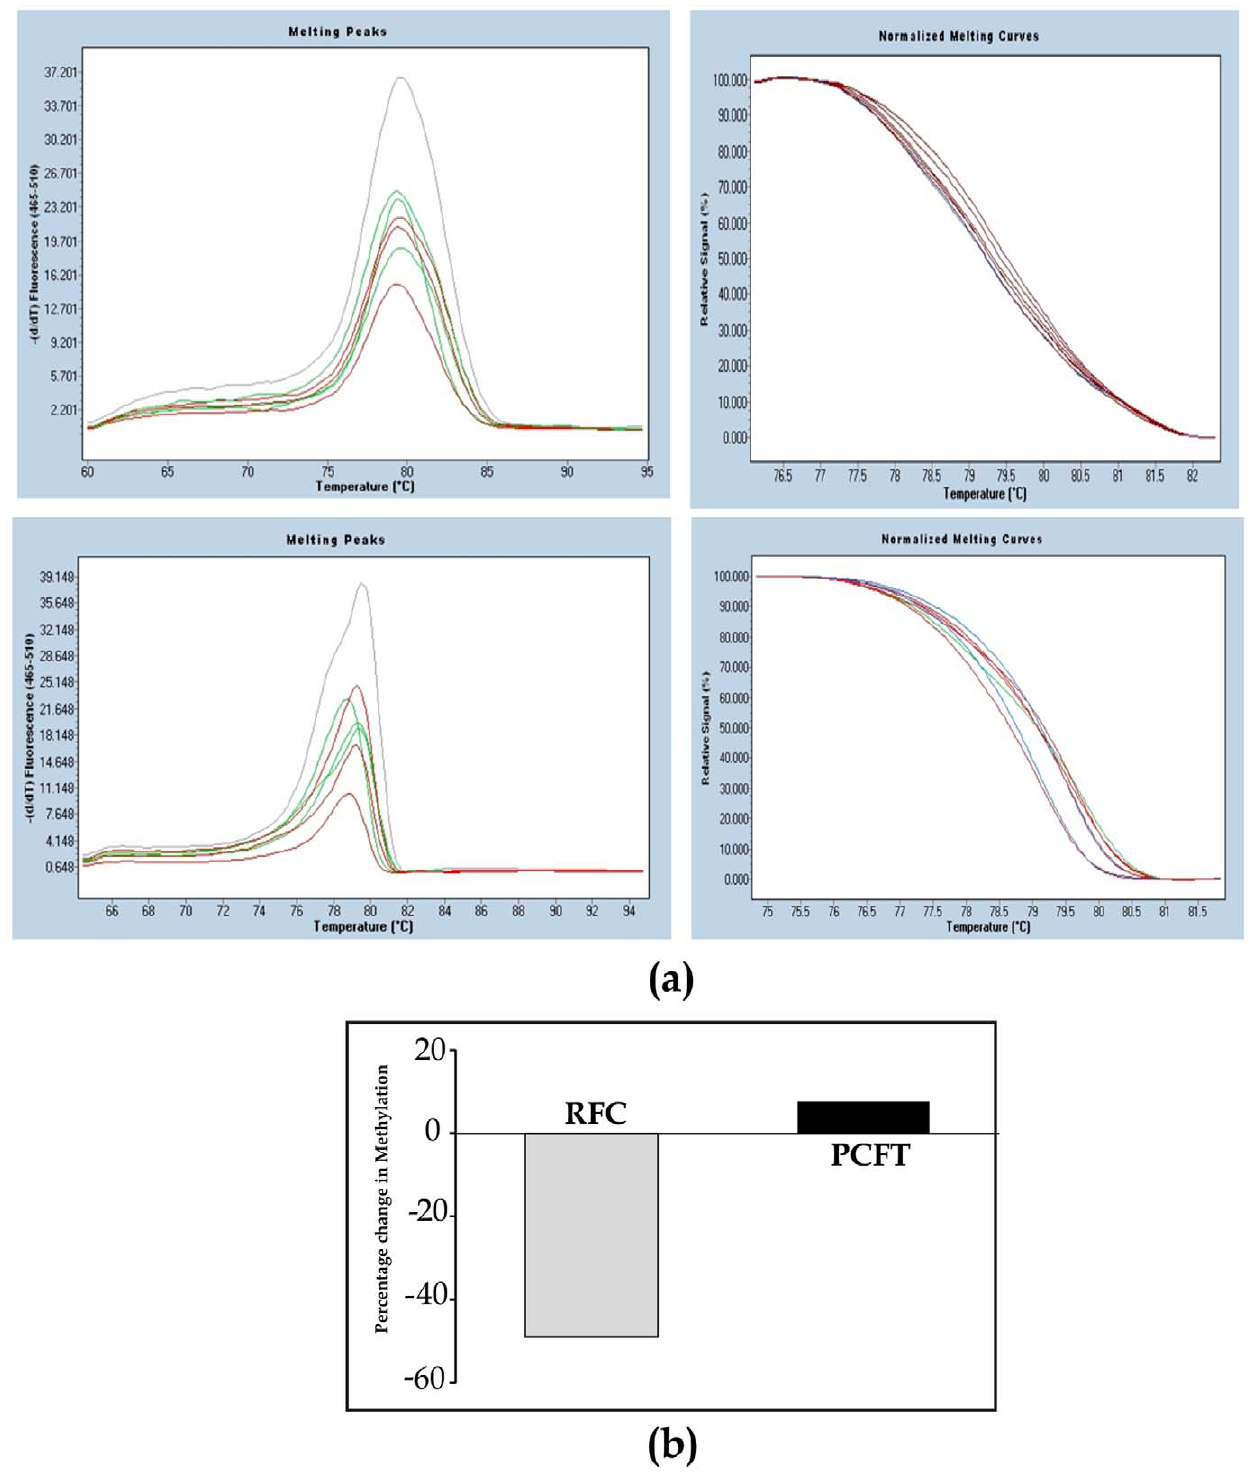
Figure 8. HRM analysis of PCFT and RFC gene (a) upper panel PCFT lower panel RFC, upper/lower panel left side melting profile and upper panel/lower panel right normalized melting curves. Curves in green; Control, red; Ethanol fed and gray; 100% methylated. (b) Percentage change in methylation of genes in ethanol fed rats compared to control. *** p , 0.001 vs. Control. doi:10.1371/journal.pone.0028599.g008 presence of PCFT and RFC in LR of the PPM of rats in branes might result in disruption of LR in chronic alcoholism. The agreement to our earlier studies in the CAM [20], suggest the reduced levels of the PCFT and RFC in the PPM as compared to alteration of the lipid composition of pancreatic plasma mem- that in the whole cell lysates in ethanol fed rats might be due to